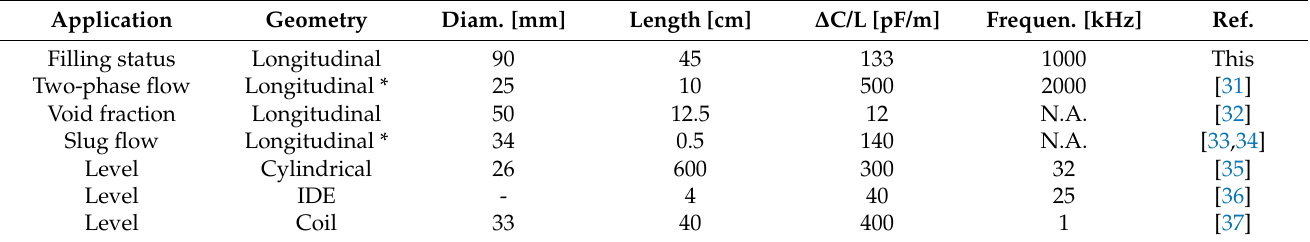
Table 1. Comparison of contactless capacitive sensors applied to pipes and